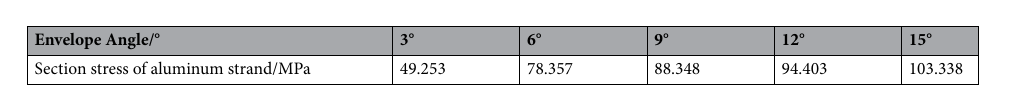
Table 11. Stress simulation results of aluminum strand under tension load of